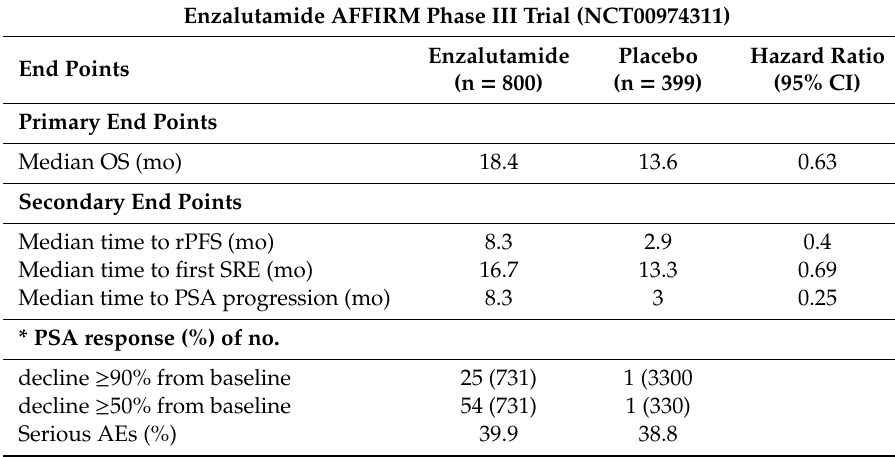
Table 3. Major therapeutic benefits brought by enzalutamide based on